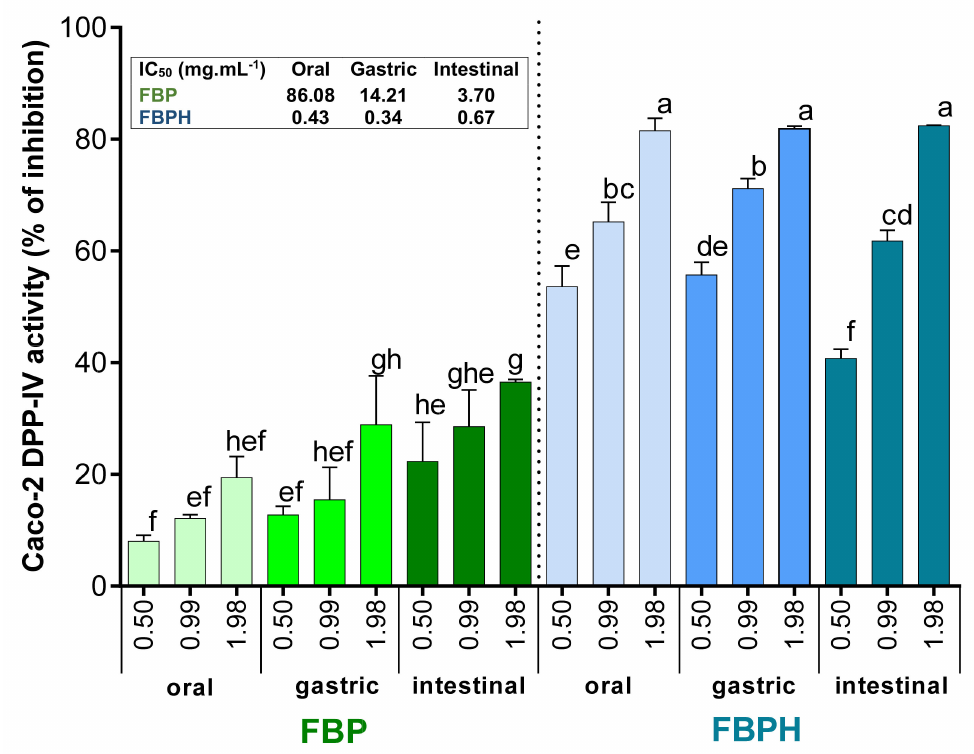
Figure 3. FBPH and FBP effects on the Caco-2 DPP-IV activity inhibition during SGID. The Caco-2 DPP-IV activity inhibition (%) obtained with FBP and FBPH digests assayed at increasing concen- trations (0.5; 0.99 and 1.98 g L − 1 , w / v ). Means without a common letter within the same graph are significantly different ( p < 0.05) using one-way ANOVA followed by Tukey post-hoc test for pairwise comparisons. Inset: IC 50 were determined by linear regression correlating the DPP-IV activity inhibition percentage and the Ln of the